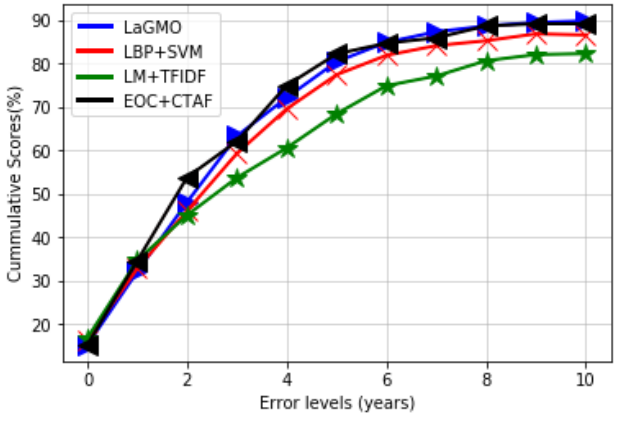
Figure 5. Comparison with similar